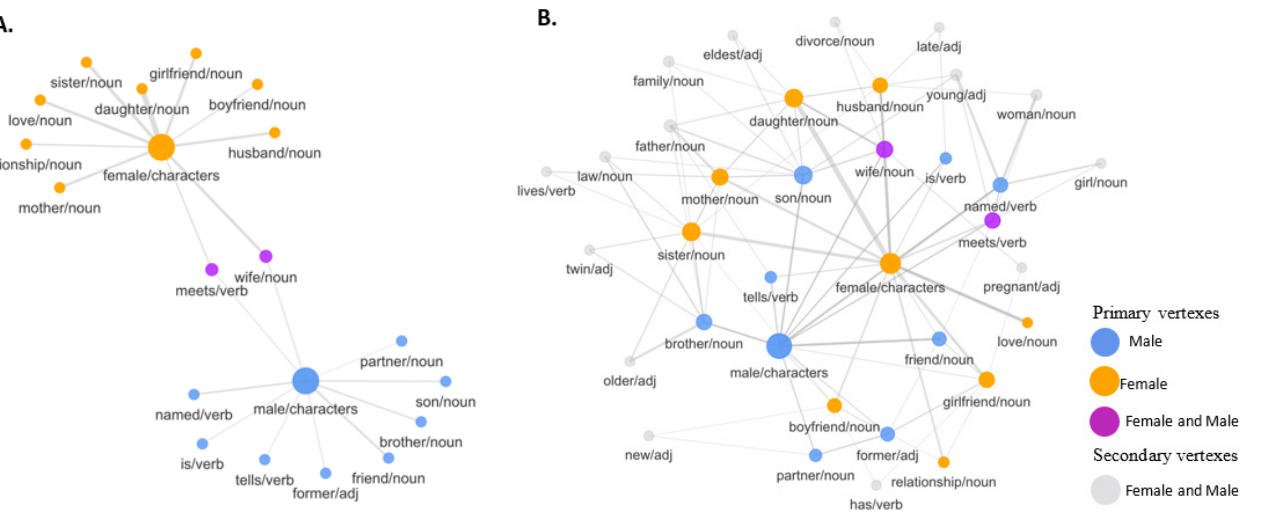
Figure 1. Details of the network construction. ( A ) Network with only primary nodes. Blue nodes represent unique associations with male characters, orange nodes represent unique associations with female characters, and purple nodes represent the common associations of both male and female characters. ( B ) Network with primary and secondary nodes. Secondary nodes are depicted in grey.